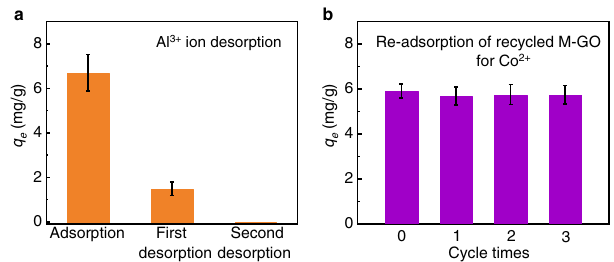
Fig. 4 | Al 3+ ion desorption and reusability of M-GO for Co 2+ adsorption. a Desorption of Al 3+ onAl 3+ @M-GO solution. b Re-adsorptionof recycled M-GO for 10mg/L of Co 2+ . Error bars indicate the standard deviation from three different